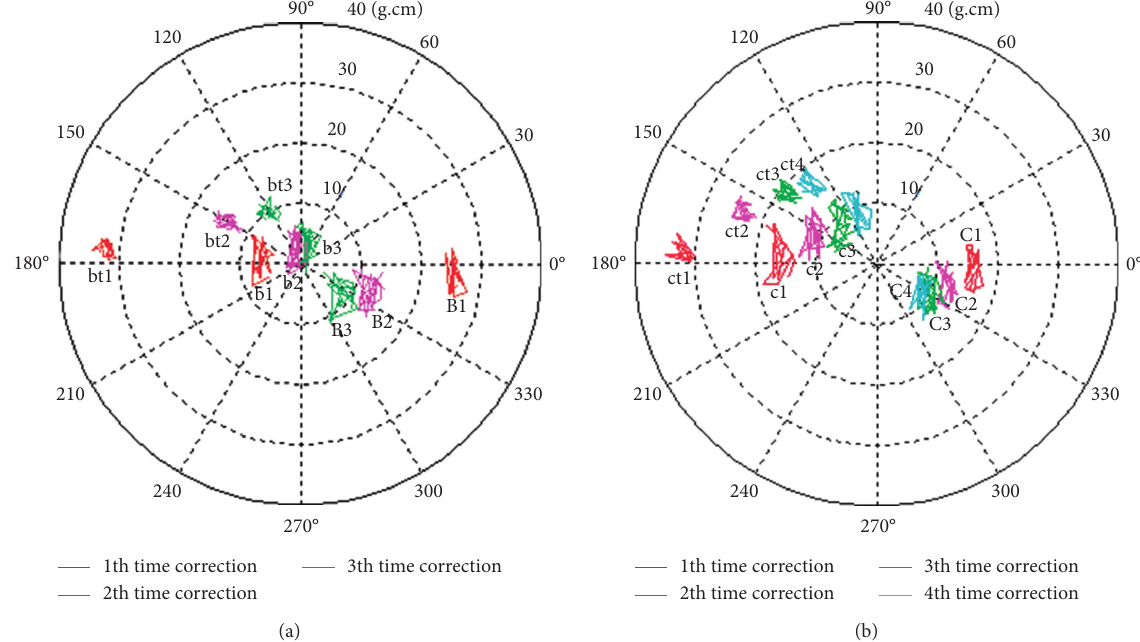
Figure 8: The iterative correcting effect with fixed weight removing rate: (a) the weight removing rate is set as 0.7; (b) the weight removing rate is set as 0.4.